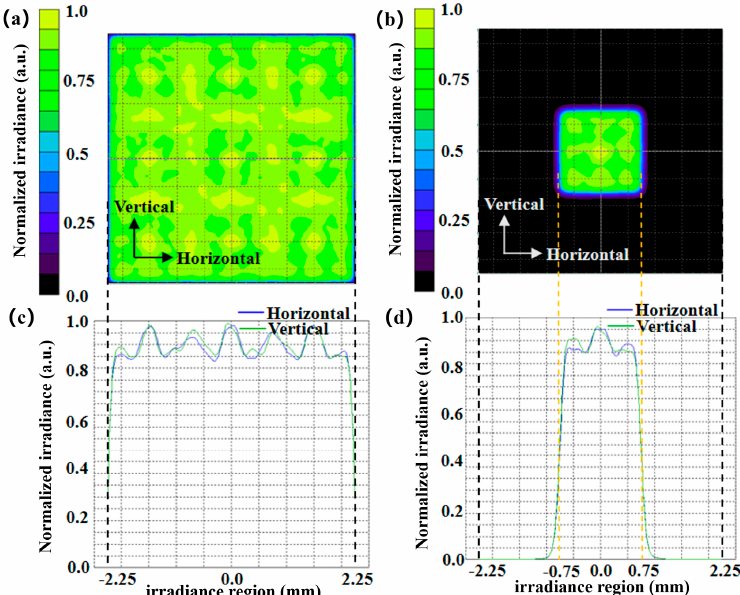
Figure 4. Simulation results of the zero-optical-distance mini-LED backlight: ( a ) 2D irradiance map and ( c ) the corresponding irradiance distribution curves when the nine local dimming zones are working at the same time; ( b ) 2D irradiance map and ( d ) the corresponding irradiance distribution curves when only the central local dimming zone is active.